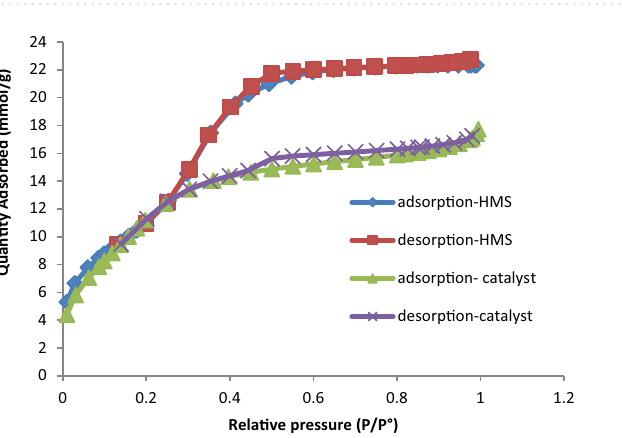
Figure 9. The map analysis of HMS/Pr-Xa-Ni.